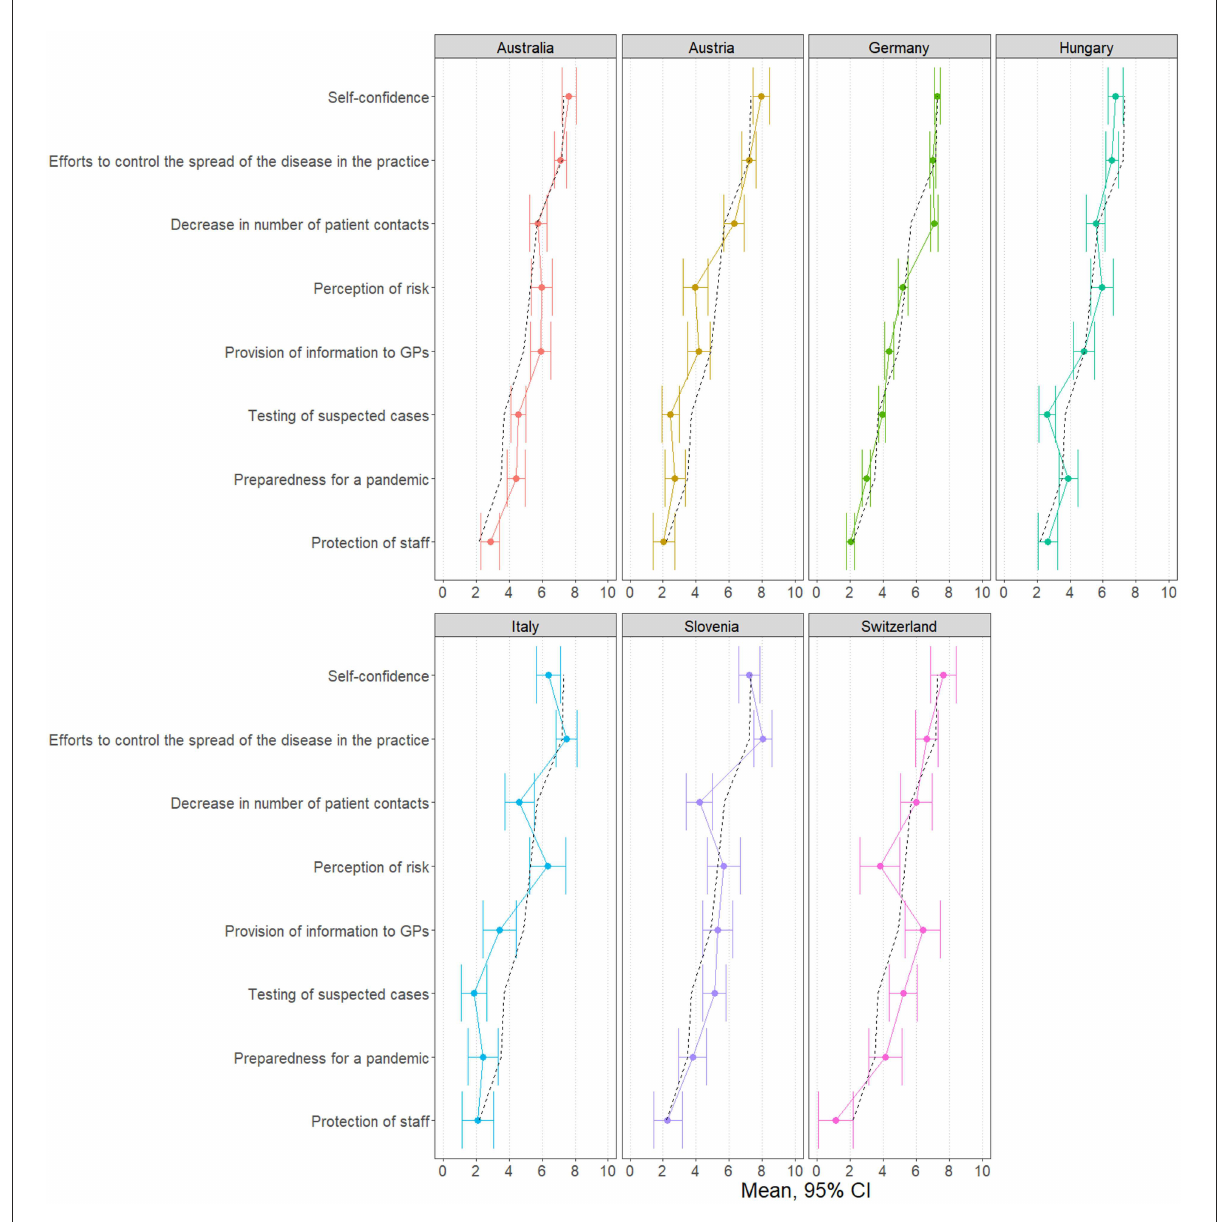
FIGURE1 Scale values for each country (dashed black line: overall mean).